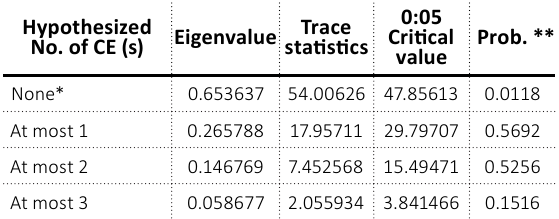
Table 4. Cointegration test results